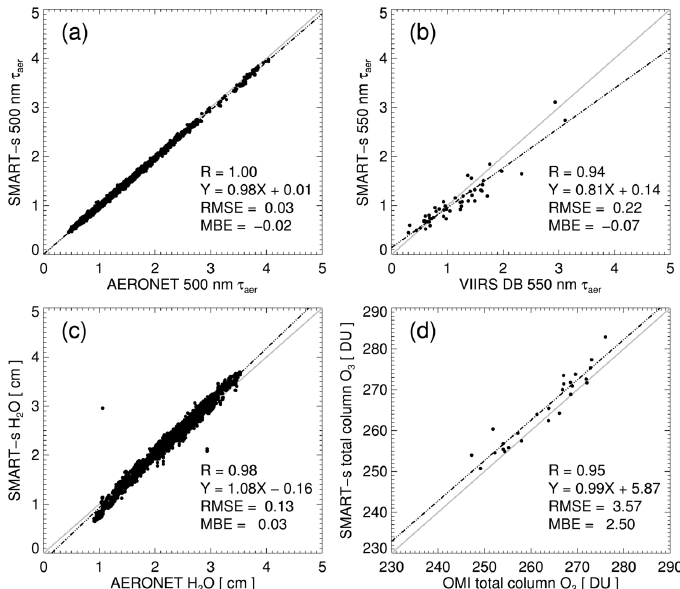
Figure A2. Panel (a) compares aerosol optical thickness ( τ aer ) at 500nm from SMART–s and AERONET (version 3, level 2.0), and panel (b) compares that at 550nm from VIIRS DB and SMART–s. Total precipitable water vapor (H 2 O) products from SMART–s and AERONET are compared in panel (c) , and total column ozone retrievals from OMI and SMART–s are compared in panel (d) . The retrievals are obtained at Fang, Thailand, from 8 March to 2 May 2019. R is the correlation coefficient, RMSE denotes root mean square error, and MBE is the mean bias error. The black dot-dashed line and the gray solid line represent regression and one-to-one line,